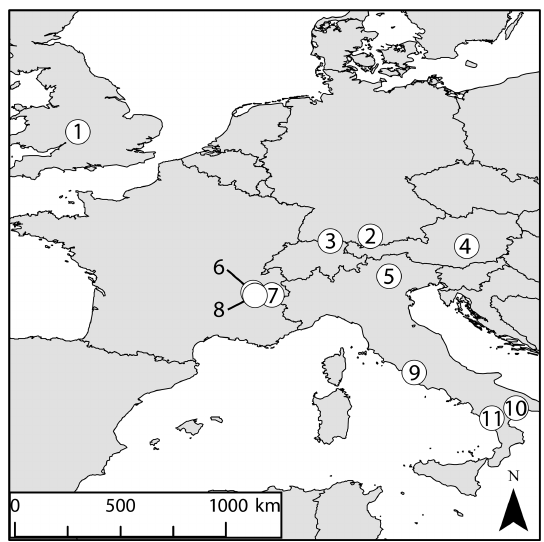
Figure 1. Locations of the monitoring sites from which data are presented: (1) River Arrow, UK; (2) River Thalhofen, Germany; (3) Murg River, Switzerland; (4) Alpine river, Austria; (5) River Brenta, Italy; (6) La Morge, France; (7) St. Julien torrent, France; (8) River La Vence, France; (9) River Tiber, Italy; (10) River Bradano, Italy; (11) River Noce, Italy. Not shown are the fol- lowing rivers in North America: (12) Castor River, Canada, and (13) Salmon River, Canada. Map spatial reference: ETRS